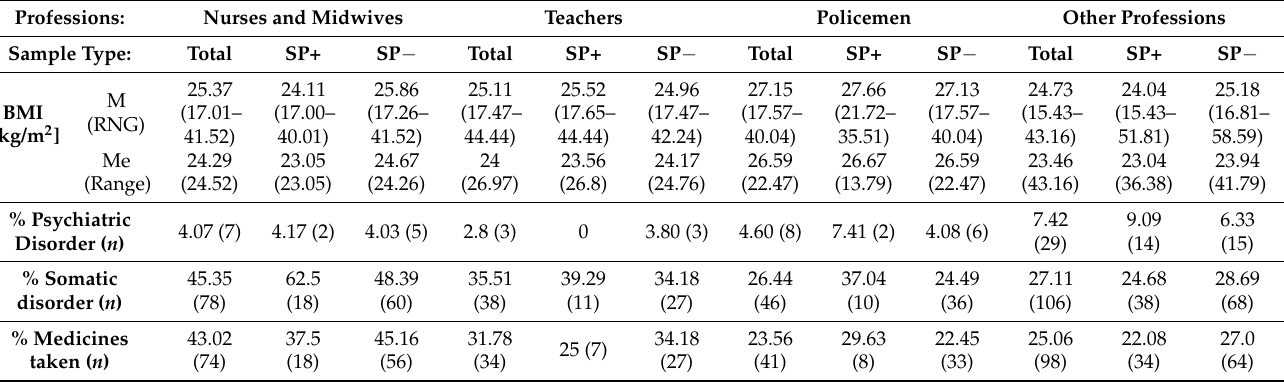
Table 2. Current health status of participants by profession